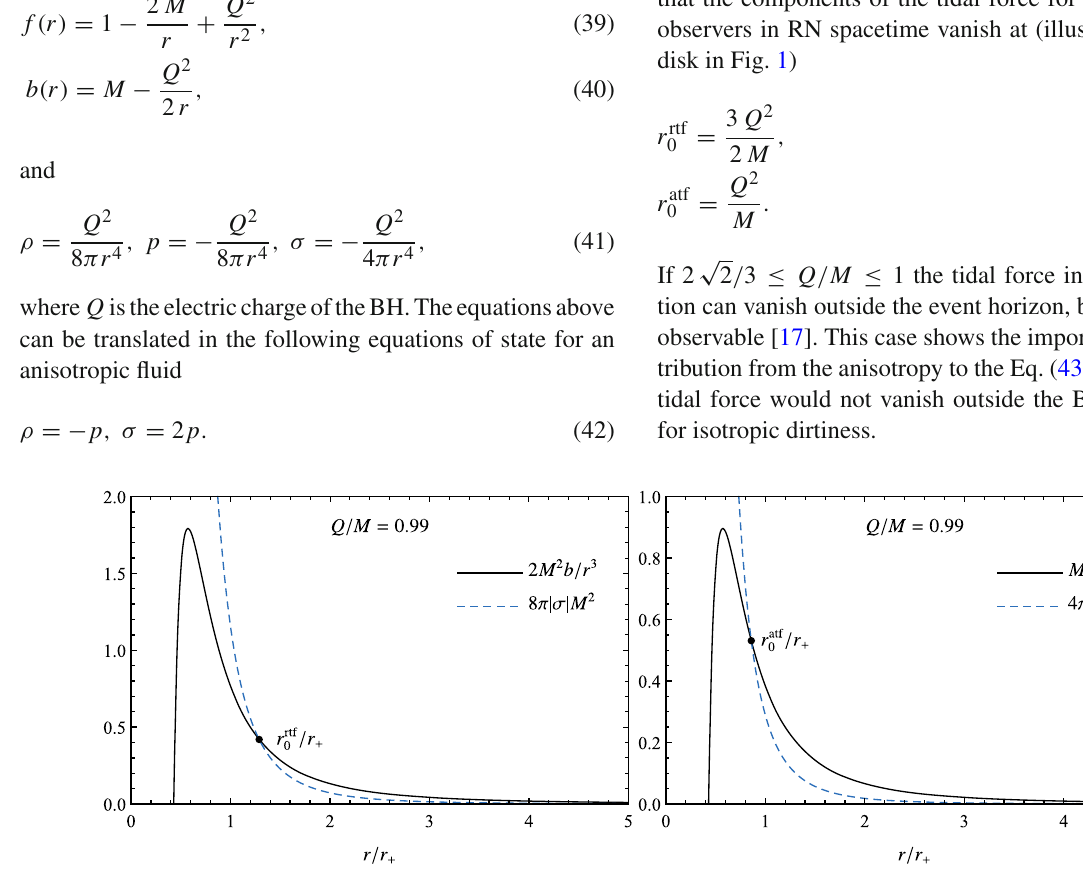
Fig. 1 Contributions from the Misner–Sharp energy b ( r ) (black solid lines) and from the matter (blue dashed lines) to the radial (left) and angular (right) tidal forces in a RN spacetime with Q / M = 0 . 99. The